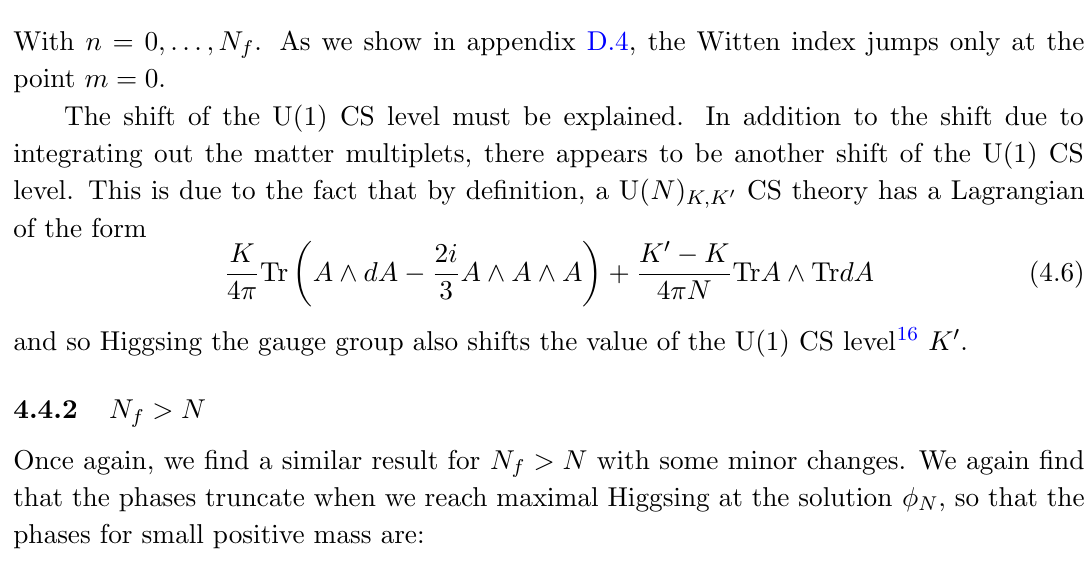
Figure 6 . Phase diagram for an N = 1 U( N ) fundamental matter multiplets. The precise form of the vacua in the intermediate phase is discussed in the